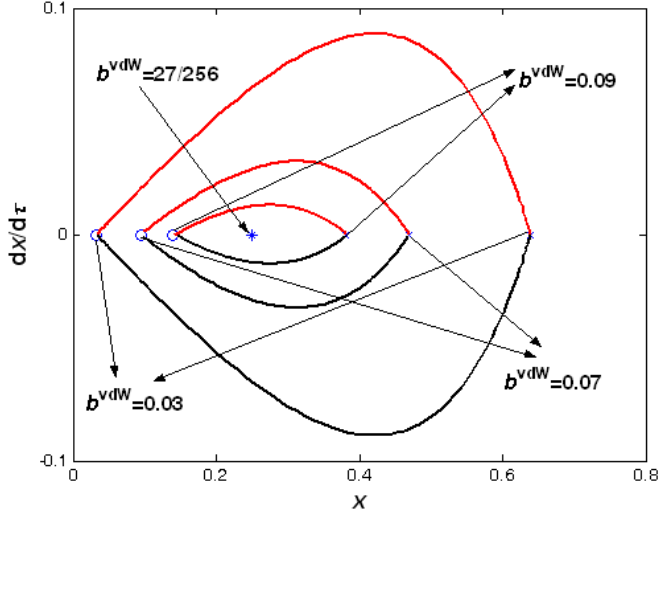
Figure 9. Heteroclinic orbits with 0 a = and vdW 0.03,0.07,0.09 b = , respectively when 3 μ=